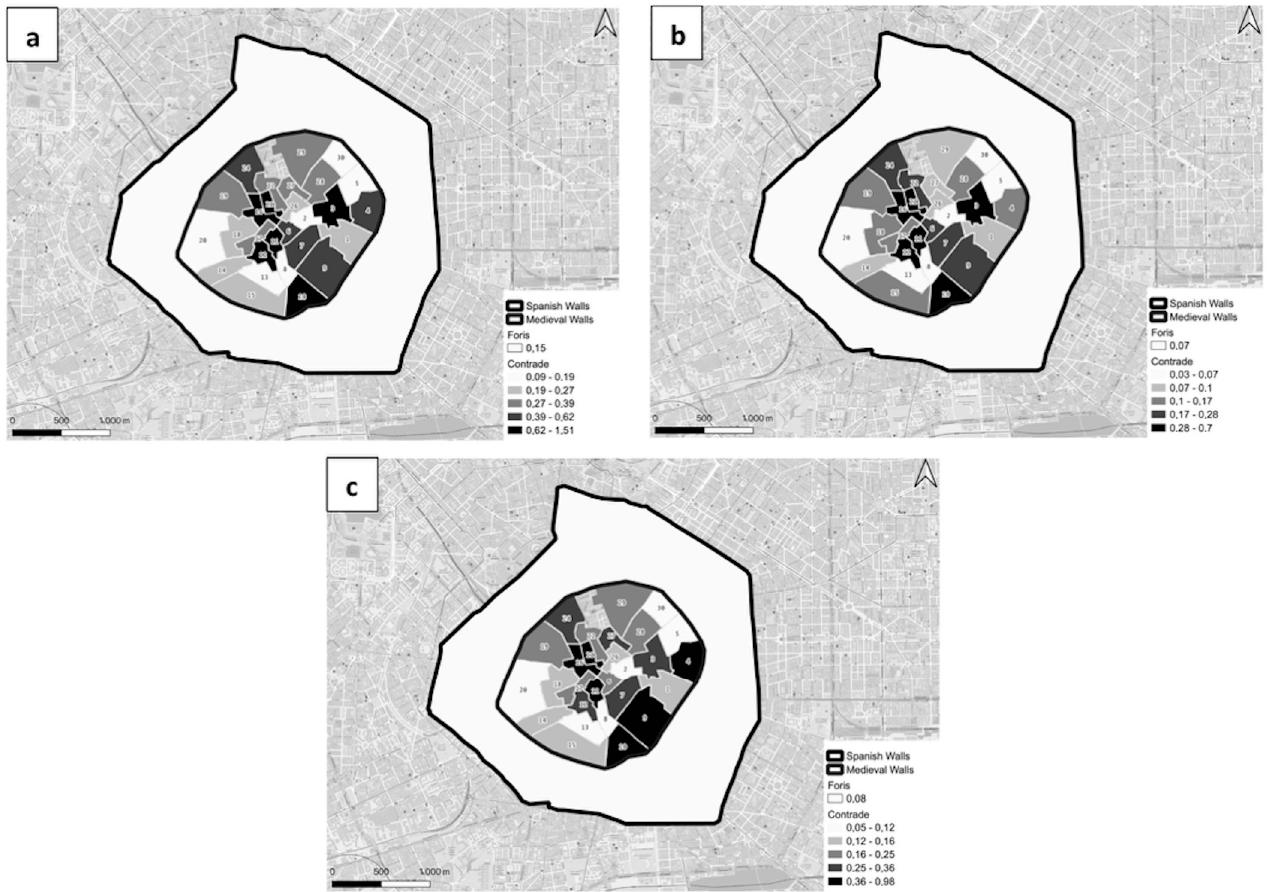
Figure 2. Distribution of the deceased people in the Contrade and the foris area for all subjects ( a ), for children (subjects under eight years old) ( b ), and adults ( c ). The names of the Contrade associated with the IDs are reported in Table 1.